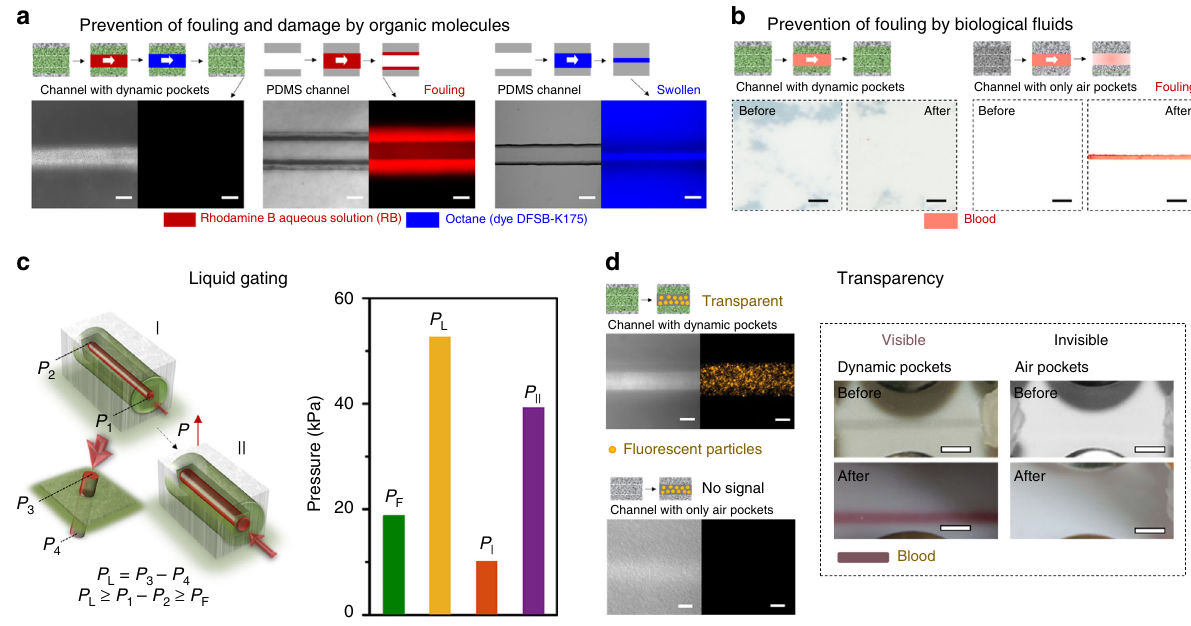
Fig. 4 Multifunctional micro fl uidics enabled by ADAPTS. a Antifouling capability of a microchannel with dynamic pockets before and after continuously transporting fi rst RB and then octane. No fouling or soaking of the channel was observed. Conventional PDMS microchannels were injected with RB and octane at the same conditions. A signi fi cant amount of residual RB is left on the walls of PDMS microchannels. Octane swells PDMS and damages the entire microchannel. Scale bar is 100 μ m. b Antifouling capability of a microchannel with dynamic pockets before and after continuously injecting blood. No fouling or soaking of the channel was observed. A liquid-free PTFE microchannel was injected with blood at the same conditions. A signi fi cant amount of residual blood is left on the walls of PTFE microchannel. Scale bar is 2 mm. c Liquid gating function of the microchannel inside the ADAPTS. The results are shown for the channel size of the length 6 cm, height 200 µ m, width 5 mm; average pore size of ~5 µ m and fl ow rate of 500 µ L/min (I) and 2.5 mL/min (II). d Fluorescent particles inside the microchannel with dynamic pockets show fl uorescent signal, while the signals are blocked by the channel with air pockets only. Scale bar is 100 μ m. Optical images of blood transport inside the microchannels with or without dynamic pockets indicates that the blood fl ow is visible inside the ADAPTS. Scale bar is 2.5 mm